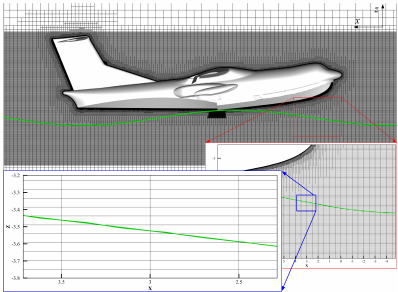
Figure 7. Computational global and zoom-in grid of the medium mesh, green curve represents the wave